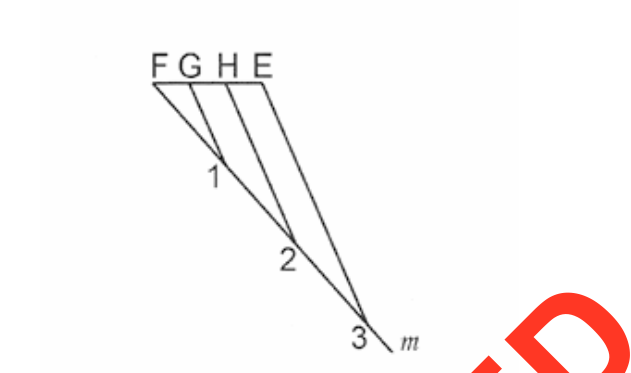
Figure 9 – Division of the length FE for angle trisection of β = 22º 30’ Рис . 9 – Длина деления отрезка FE по трисекции угла β = 22º 30’ Слика 9 – Подјела дужи FE за трисекцију угла β = 22º